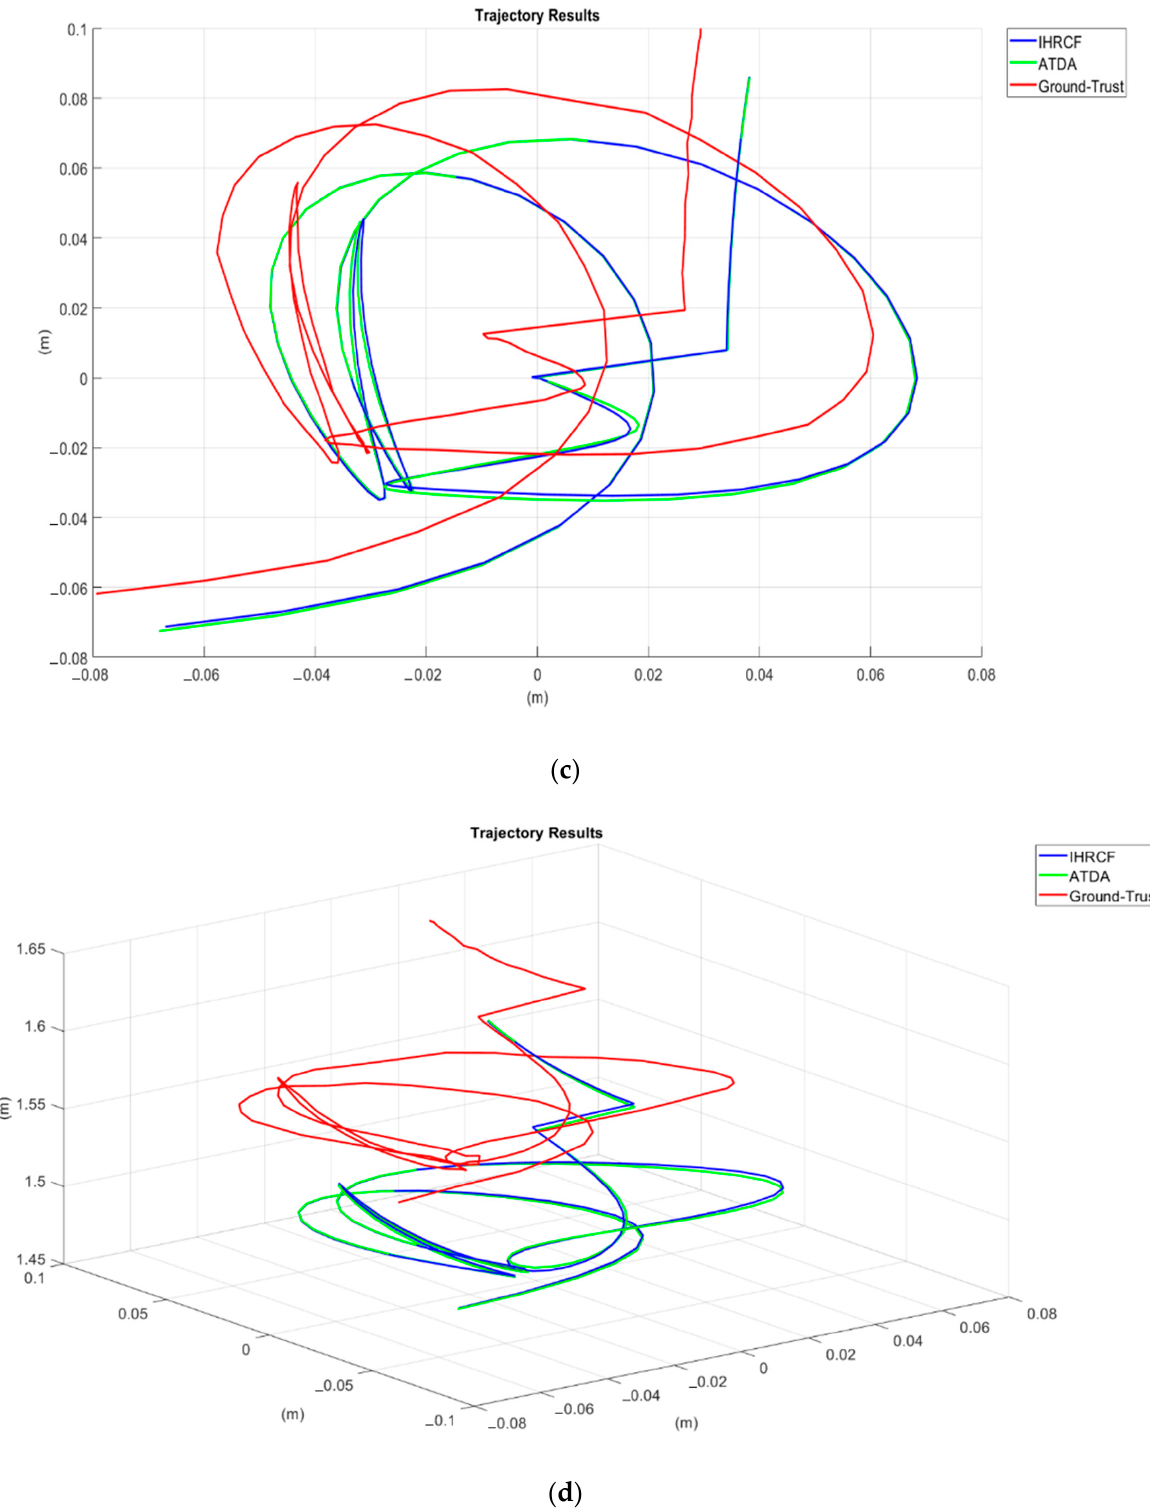
Figure 16. Plots of 3D trajectories of the Stewart platform using the IHRCF, ATDA base pose estimation and the GT, with the X-Z view, Y-Z view, X-Y view, and 3D trajectory displayed in ( a – d ), respectively.